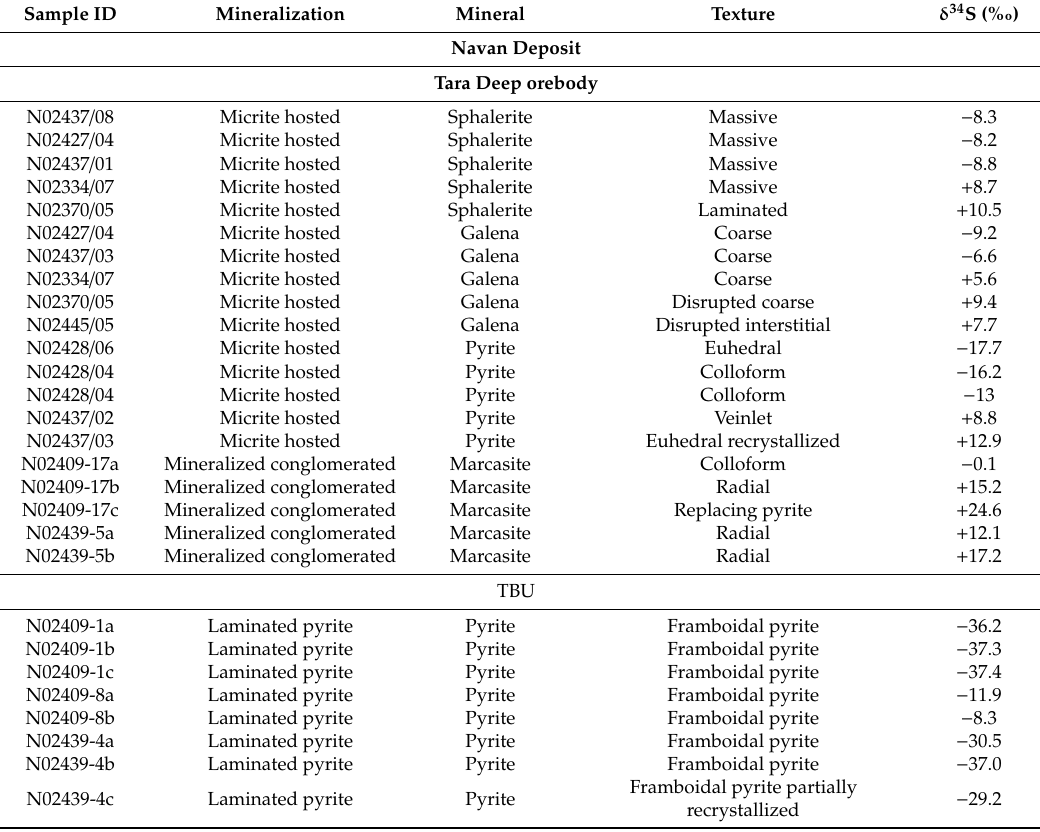
Table A1. S isotope data from Tara Deep, TBU (Navan) and Main zone and Island Pod